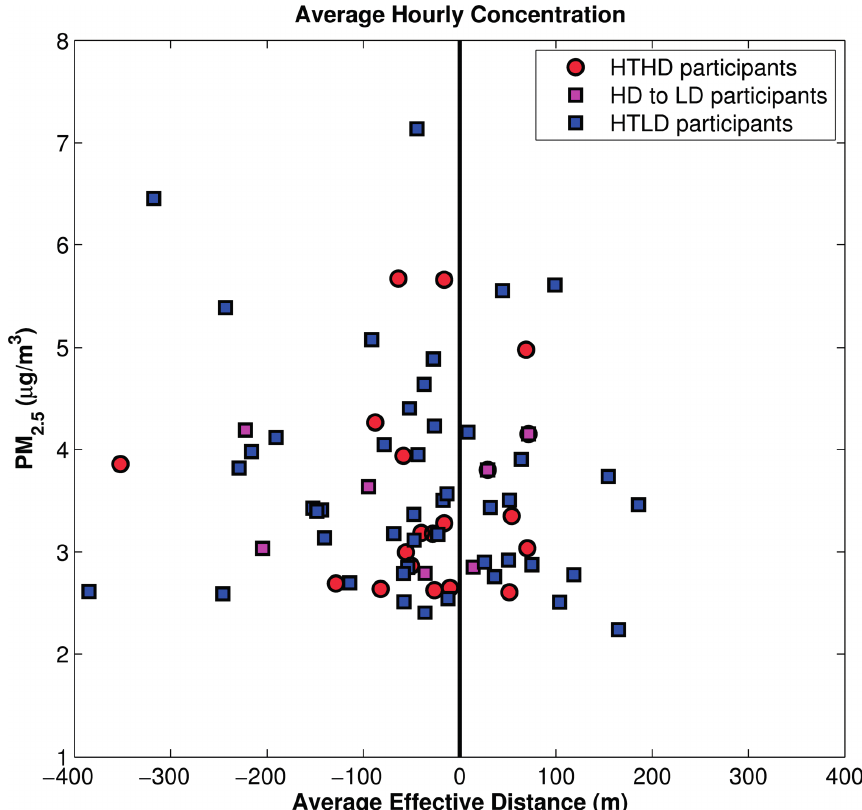
vs. effective distance for HTHD 2.5